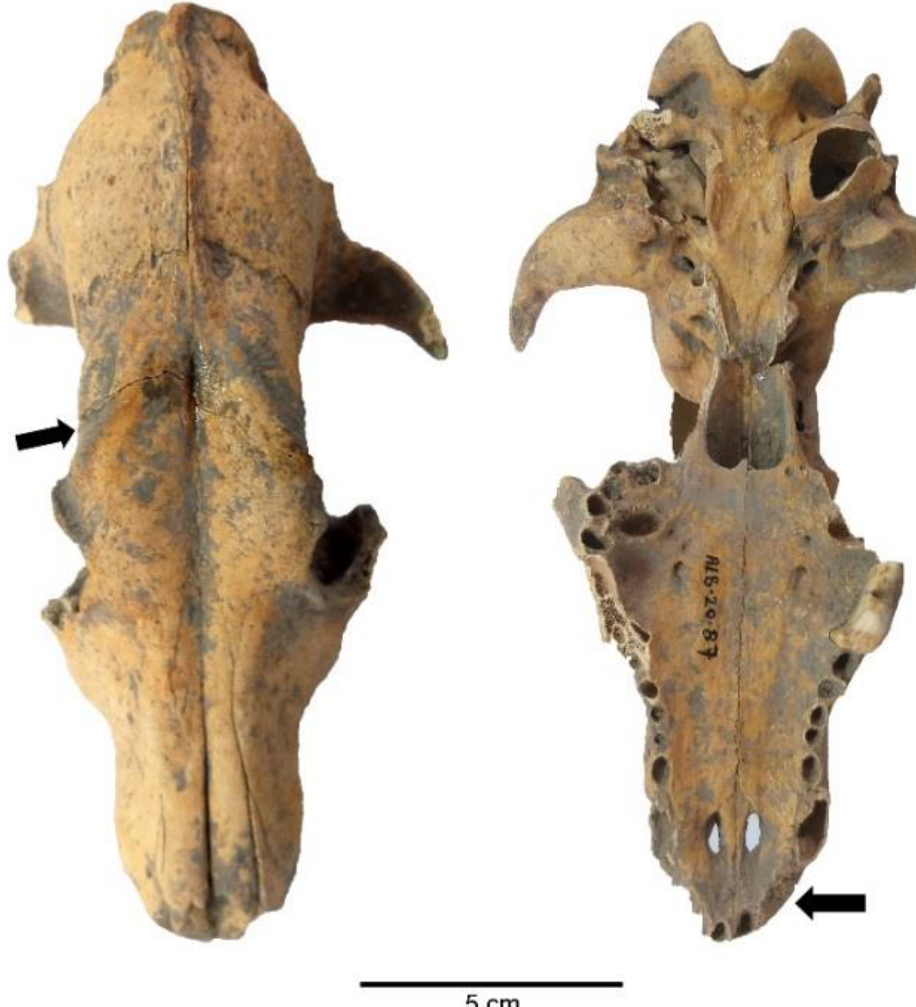
Figure 7. A dog skull from Alaybeyi Höyük with a healing fracture ( left arrow ) and oligodontia ( right arrow ).